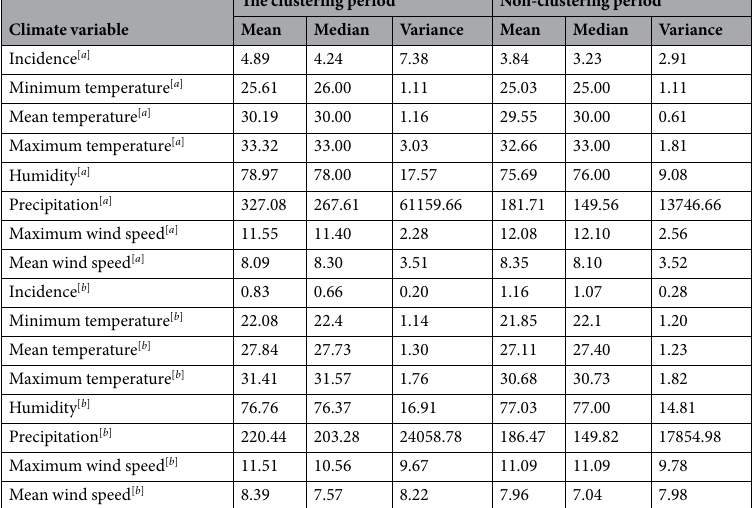
commuting in and out of the city daily 21 . High temperature, high humidity, heavy rainfall, low wind speed, high population density, and large mobility contribute to high dengue incidences in Colombo.The public sector costs of dengue control activities and the direct costs of hospitalizations in Colombo district were estimated to be high